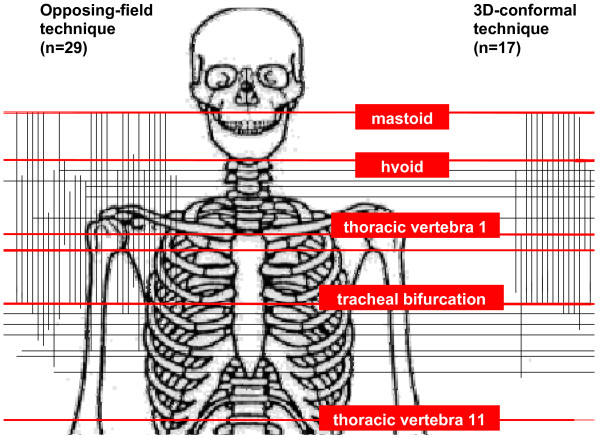
Overview of anatomic positions of upper and lower field borders as used in opposing-field techniques and 3D-conformal techniques for anaplastic thyroid cancer (combinations of both techniques used in some patients).